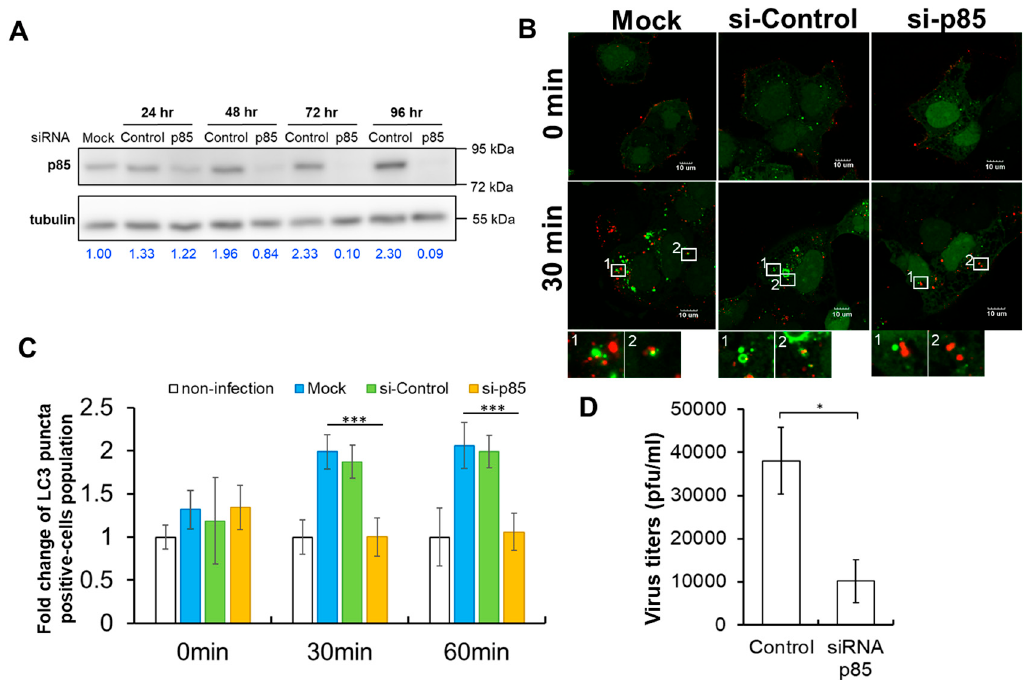
Figure 5. The involvement of p85 in TIM-1-mediated DENV-induced autophagy and virus production. ( A ) The expression of p85 in GFP-LC3-Huh7.5 cells transfected with either non-targeting siRNA or siRNA against p85 was analyzed by a Western blot assay at 24, 48, and 72 h post-transfection. Mock indicated the parental GFP-LC3-Huh7.5 cells without siRNA transfection. Numbers at the bottom represent the fold changes of the expression of p85 normalized with one in the mock group. ( B ) The formation of autophagosomes (green) and the distribution of Atto647N-DENV particles (red) in GFP-LC3-Huh7.5 cells treated either with si-control or si-p85 prior to DENV infection at a MOI of 10 were visualized by Olympus FluoView 1000 confocal microscopy at 0 and 30 min post-infection, respectively. The insets showed no colocalization of Atto647N-DENV signals with LC3 puncta in si-p85-treated cells. The scale bar represents 10 µ m. ( C ) The e ff ects of either si-control (red) or si-p85 (yellow) treatment on the formation of autophagy in GFP-LC3-Huh7.5 cells was determined by the percentage of autophagy-positive cells. The siRNA-free group is indicated as mock (blue). GFP-LC3-Huh7.5 cells without both DENV infection and siRNA transfection were indicated as non-infection (white). The error bars represent standard deviations from three independent experiments ( > 200 cells). *** p < 0.001. ( D ) The e ff ects of p85 on DENV production were examined. GFP-LC3-Huh7.5 cells were treated with si-p85 prior to DENV infection. The titers of the extracellular virus were measured by a plaque assay 48 h post-infection. The means of three independent experiments performed in triplicate are shown. * p <